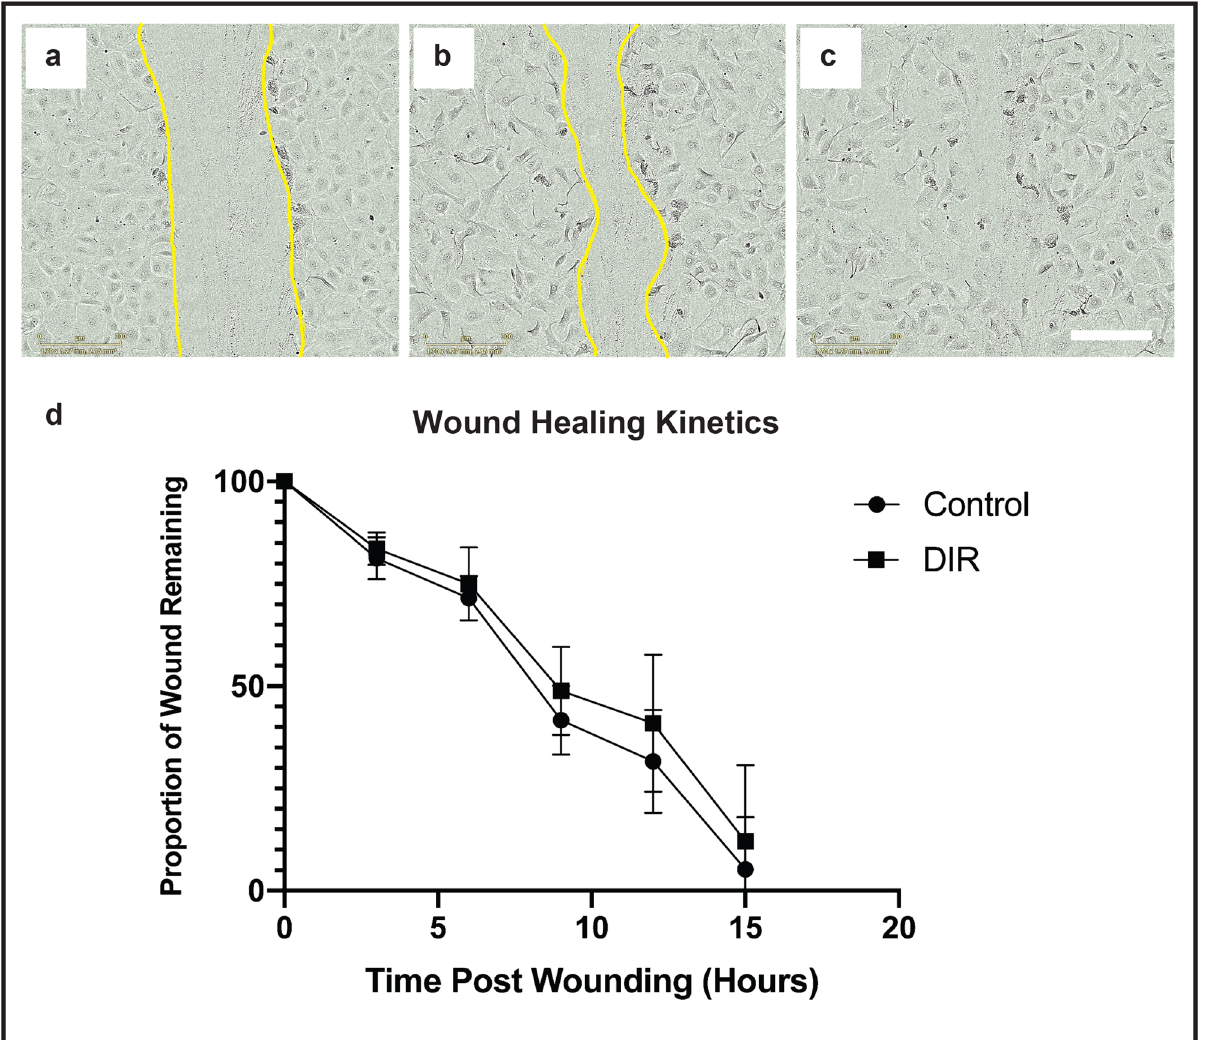
Figure 2. Wound healing in DIR-labelled primary human CECs. ( a ) Human CECs were plated and allowed to stabilize. A standard scratch wound was made with a 10 µl pipette tip. Th original wound area was delineated (yellow border) and the wound area measured. Time-lapse images were taken every hour after wounding. ( b ) The wound area was reassessed serially (yellow border), and the percentage wound area remaining calculated. ( c ) Imaging was continued until complete closure of the scratch wound was observed. ( d ) The wound area remaining (mean and standard deviation) was compared between paired CEC controls vs CEC exposed to DIR every 3 h for 15 h. (N = 6, paired t-test). No significant difference between controls and DIR stained cells was seen at any time point. Scale bar: 250 on day 1 showed no change in corneal clarity (Fig. 3a). DIR stained endothelial cells were visible on infra-red imaging, with significant cell-to-cell variation in staining intensity observed (Fig. 3b). There was no increase in corneal thickness (Fig. 3c,f) at any time point after surgery, with CCT remaining < 400 µm throughout the obser- vation period. At day 28, all corneas remained clear (Fig. 3d). DIR labelled cells were still visible, but with some reduction in observable fluorescence (Fig. 3e). DIR uptake was prominent in the iris, meaning that pupil dilation was necessary to reduce background fluorescence in subsequent examinations. Background fluorescence was